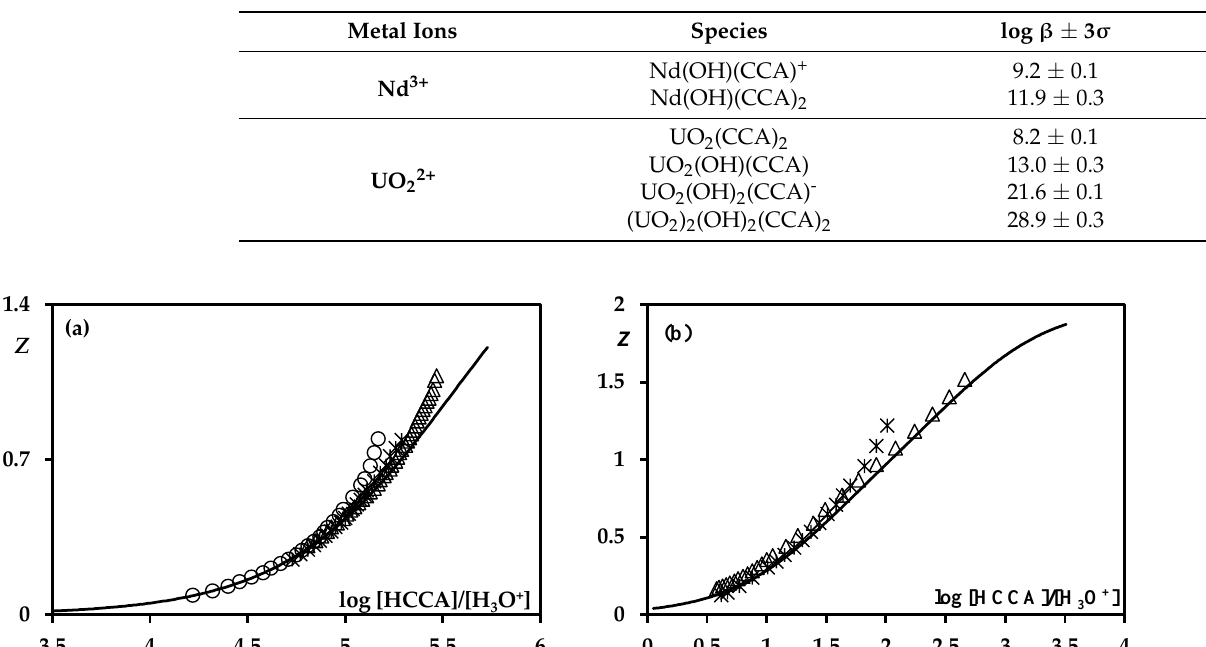
Table 1. Formation of complexes of coumarin-3-carboxylic acid with Nd 3+ and UO 22+ according to Equation (2). Values of log β in NaClO 4 0.16 mol/L at 37 ◦ C were obtained by numerical procedure. Standard deviations are reported as 3 σ .